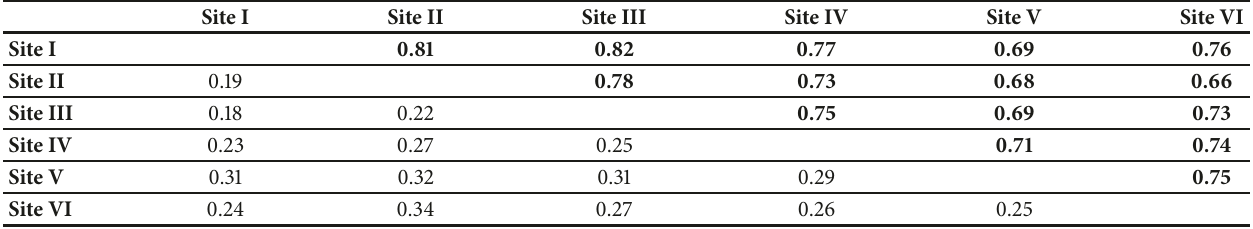
Table 18: Index of similarity and dissimilarity among different sites for Parsa Wildlife